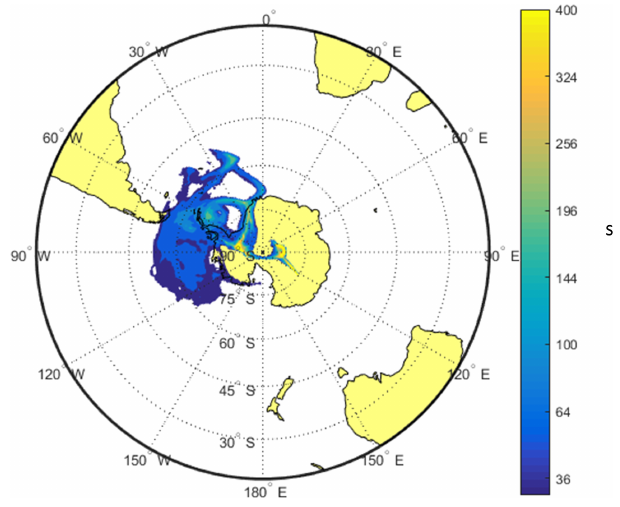
Figure 7. FLEXPART footprint of the overall highest day of scat- tering in winter 2011, on 28 July 2011, indicated by the number (3) in Fig.